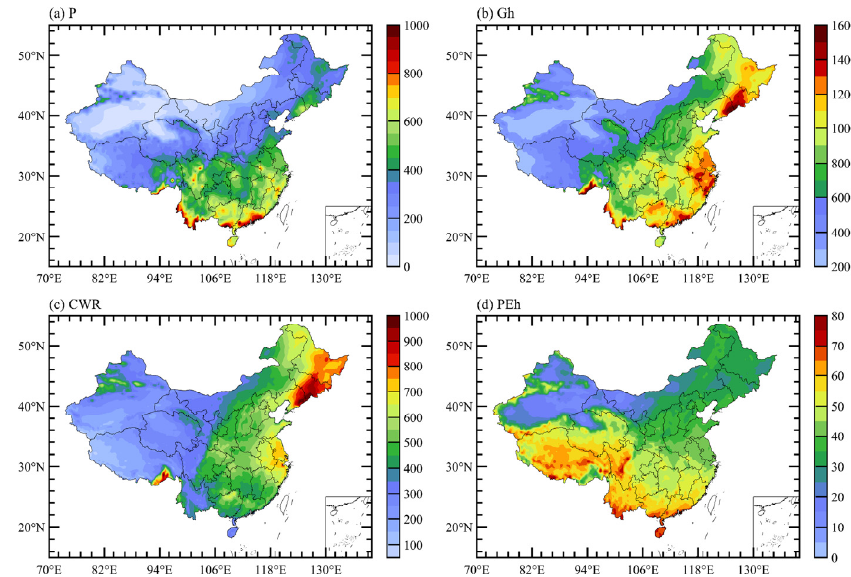
Figure 8. Spatial distribution of summer annual average of ( a ) total surface precipitation (P, unit: mm), ( b ) total atmospheric hydrometeors (Gh, unit: mm), ( c ) cloud water resource (CWR, unit: mm) and ( d ) precipitation efficiency of hydrometeors (PEh, unit: %) in China during the summers of 2001–2020.